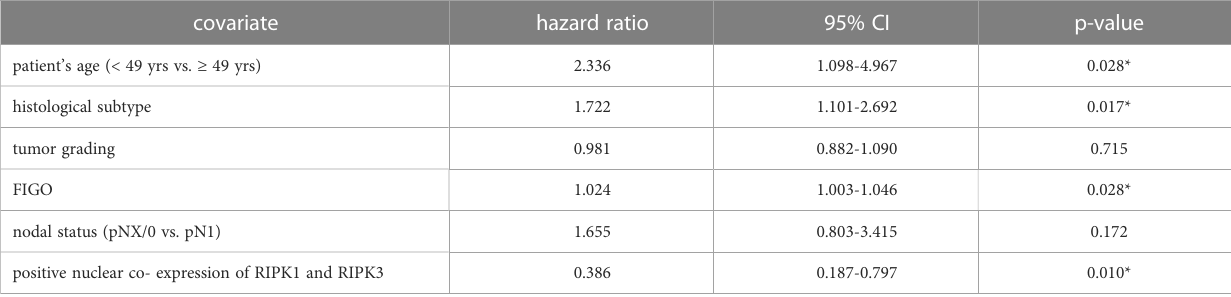
TABLE 6 Multivariate Cox regression analysis of cervical cancer patients ( n = 250) and their clinical and pathological characteristics including nuclear RIPK1-RIPK3 co-expression regarding OS.